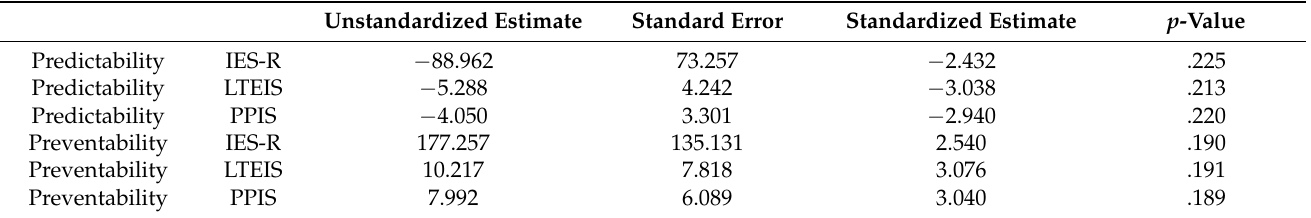
Figure 2. Path analysis for the short-term (IES-R), long-term emotional (LTEIS), and long-term professional (PPIS) impact of client suicide as predicted by Predictability vs. Preventability. Table 3. Regression weights for Predictability and Preventability predicting short- and long-term outcomes of client suicide.